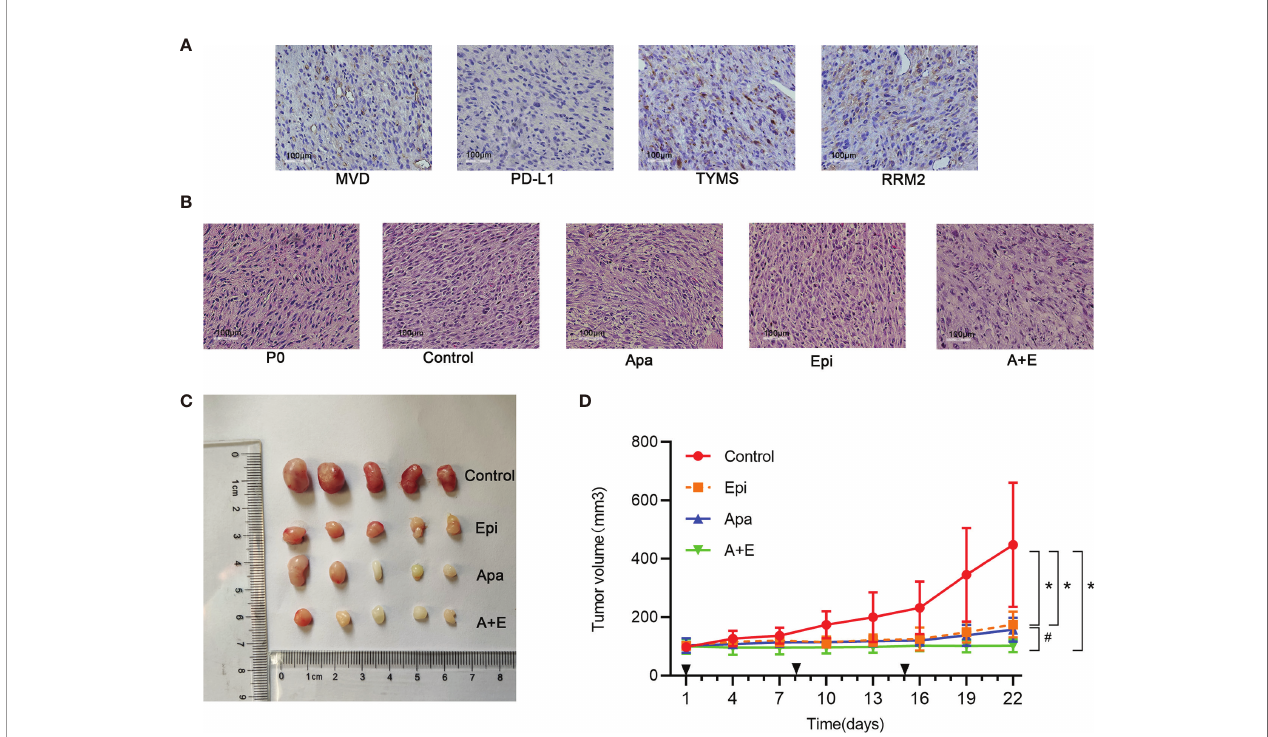
FIGURE 6 | ApatinibanditscombinationwithEpirubicininhibitedliposarcomaproliferation invivo . (A) RRM2,TYMS,andPD-L1expressionandmicrovesseldistributionin primary RLPStissue.×200magni fi cation. (B) TypicalH&Estainingoftumorsections ineachgroupandprimaryRLPStissue.×200 magni fi cation. (C) Macroscopicexamination of resectedtumorsineachgroup. (D) Tumorgrowthcurvesforcontrolgroup,single-druggroup,andcombinationgroup.*forcomparisonbetweenadministrationandcontrolgroups; *P < 0.05; # for comparison between Apatinibgroupand combination group; # P < 0.05; Apa, Apatinib; Epi, Epirubicin; A+E, combination ofApa andEpi.